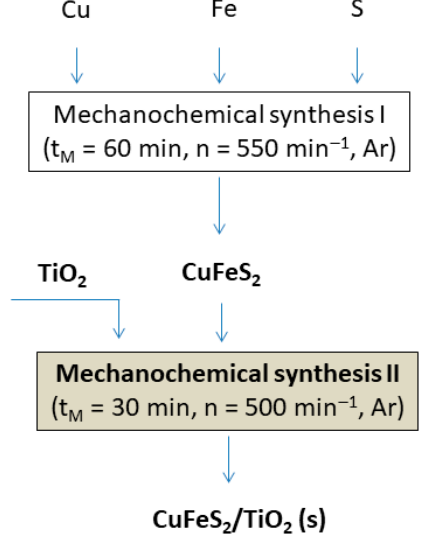
Figure 1. Flowsheet of the CuFeS 2 /TiO 2 nanocomposite preparation.